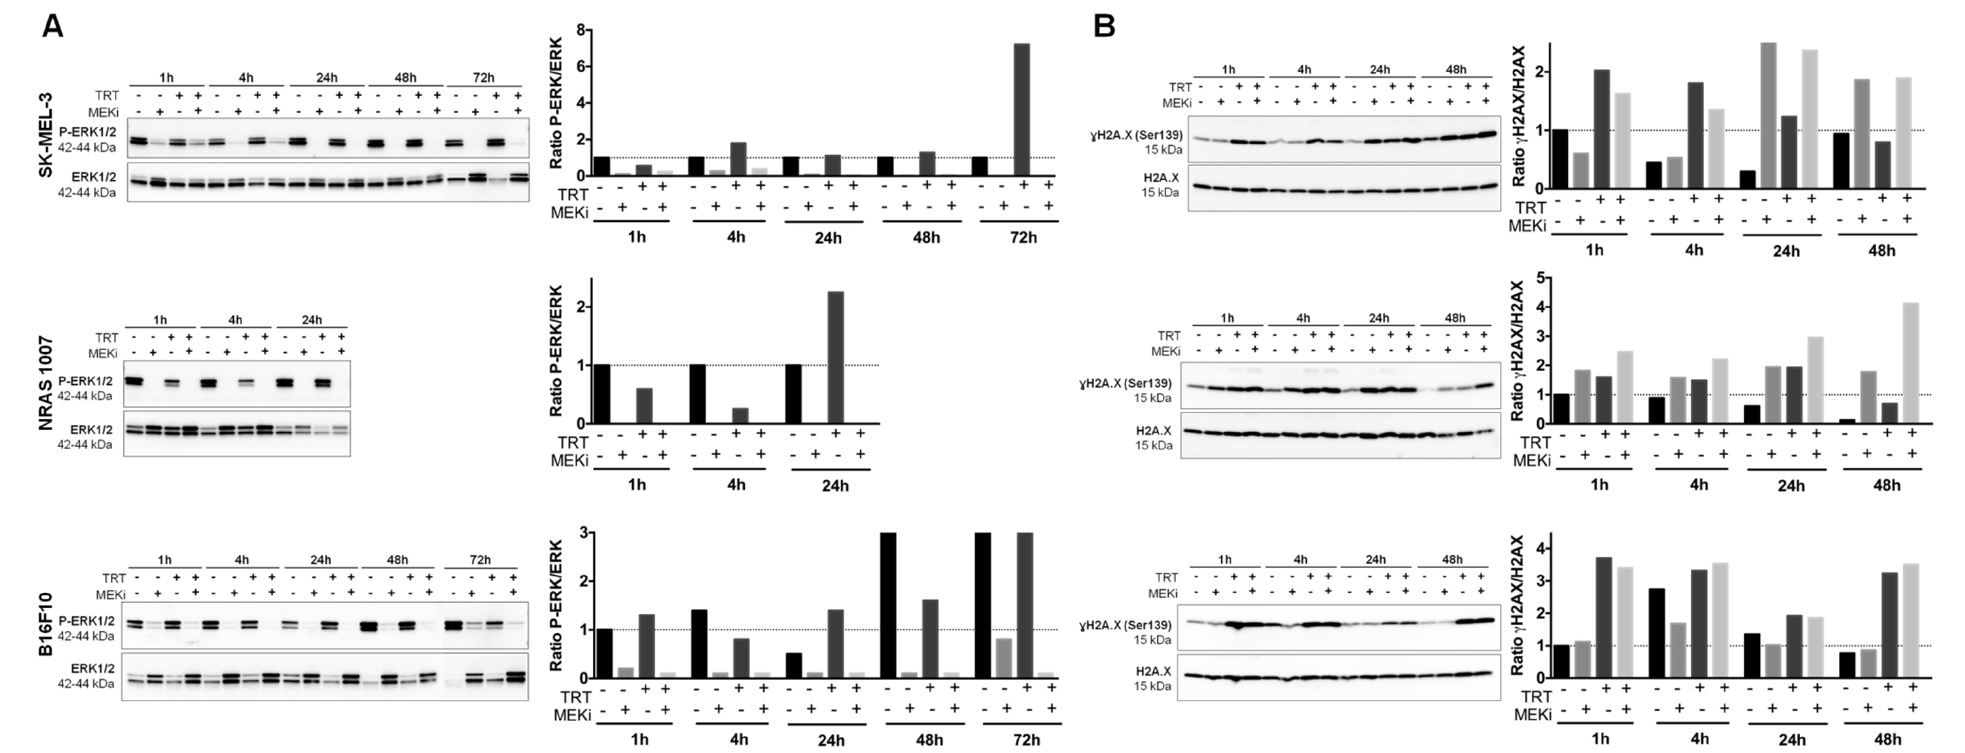
Figure 2. Quantification of p-ERK expression and analysis of DNA damage in melanoma spheroids following treatment with [ 131 I]ICF01012-TRT, MEKi, or both. ( A ) Western blot analysis of P-ERK1/2 and ERK1/2 of total cellular protein extracted from SK-MEL-3, NRAS 1007, and B16F10 spheroids treated or not with TRT, MEKi, or both for the indicated times. The density of each P-ERK1/2 band was corrected using the density of the corresponding total ERK1/2 band. All values were normalized to the control (1 h). ( B ) The expression of phospho-H2A.X ( γ H2A.X) and total H2A.X were analyzed by Western blotting for SK-MEL-3, NRAS 1007, and B16F10 spheroids treated or not with TRT, MEKi, or both for the indicated times. The density of each γ H2A.X band was corrected using the density of the corresponding total H2A.X band. For Western blot, spheroids from 3 different experiments were pooled. In graphs, y-scales are not identical between cell lines.